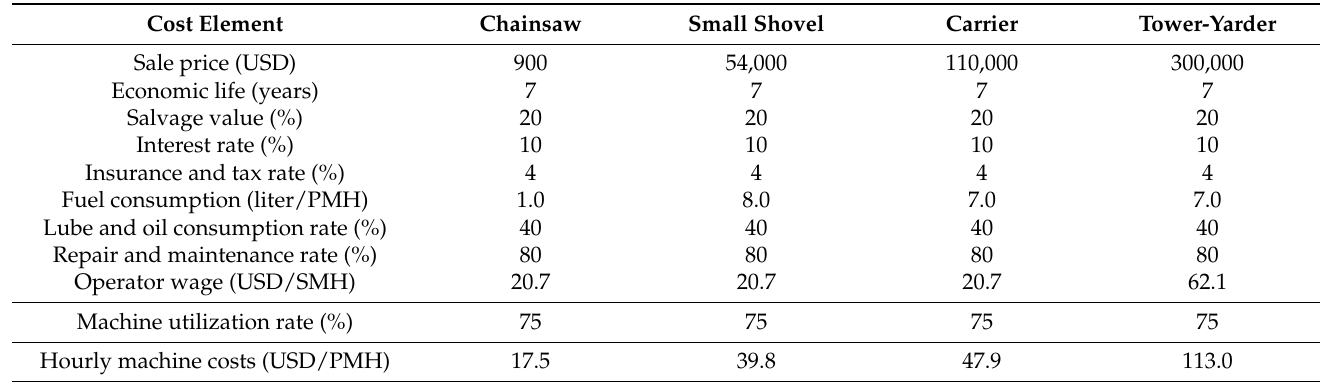
Table 4. Cost elements and hourly machine costs for each piece of harvesting